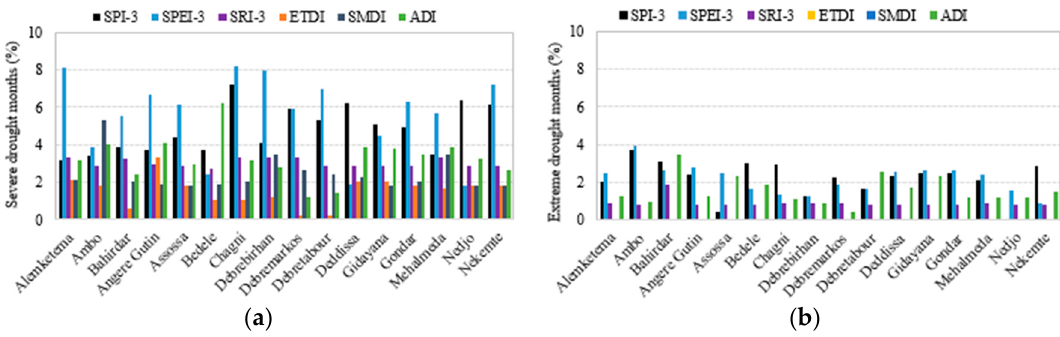
Figure 4. Percentage of severe ( a ), and extreme ( b ) droughts months observed for the drought indices within the study period (1970–2010) for the selected meteorological stations.